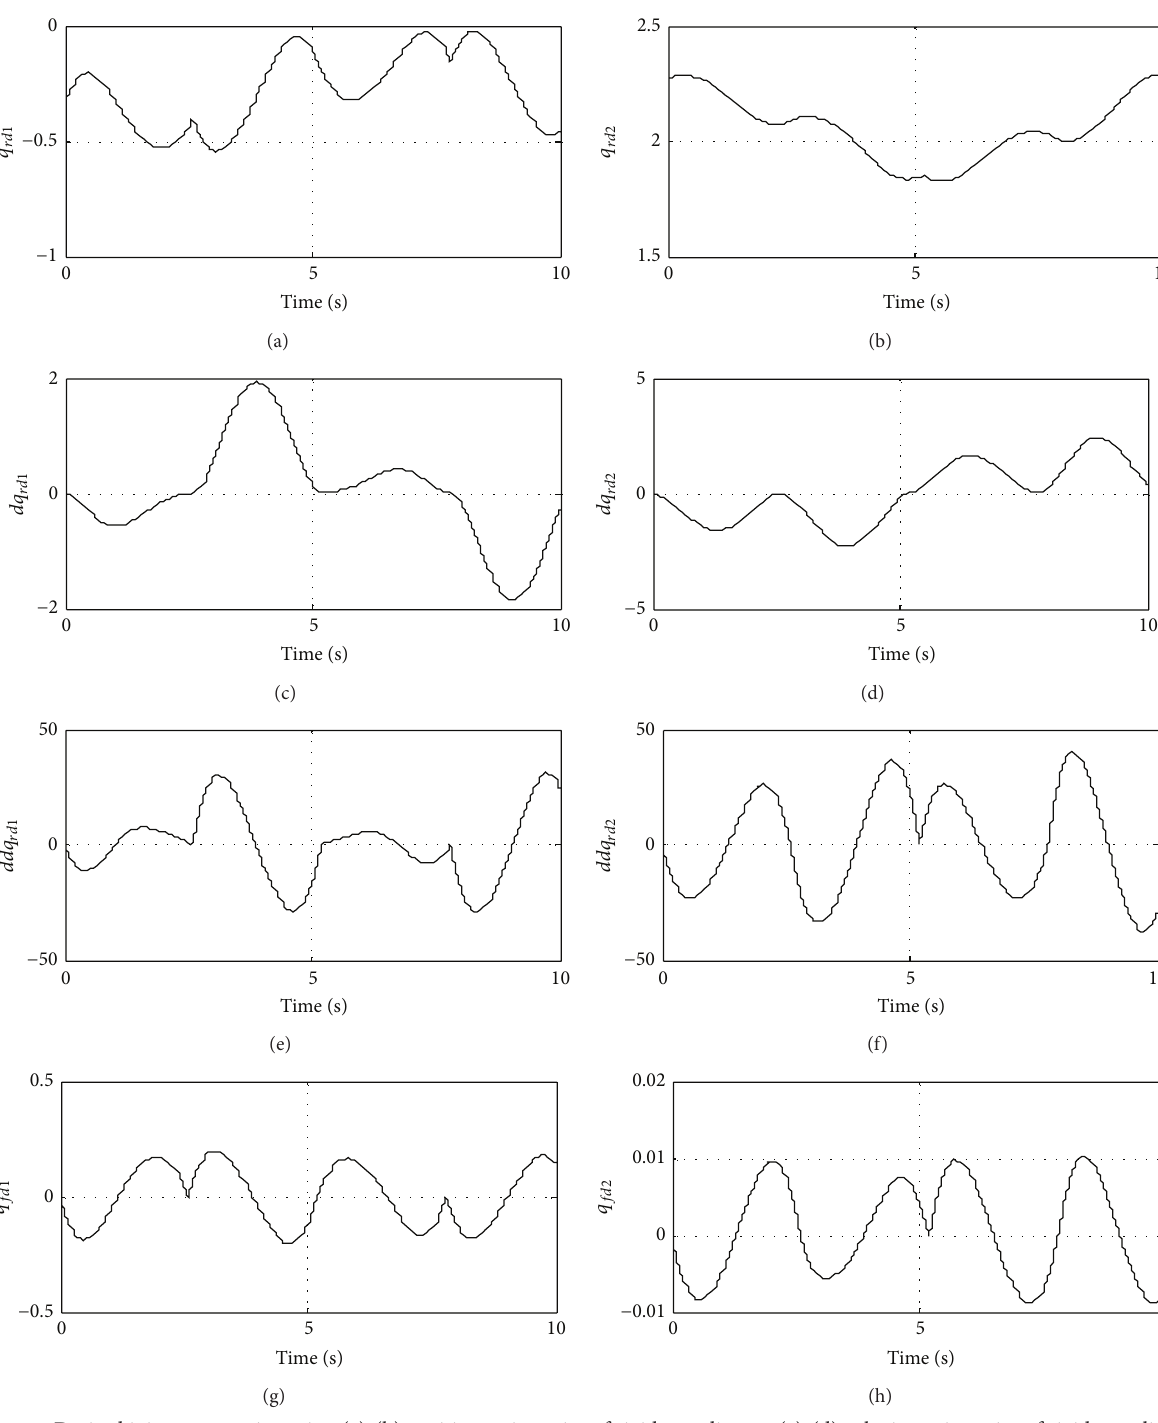
Figure 7: Desired joint space trajectories: (a)-(b) position trajectories of rigid coordinates, (c)-(d) velocity trajectories of rigid coordinates, (e)-(f) acceleration trajectories of rigid coordinates, and (g)-(h) position trajectories of flexible